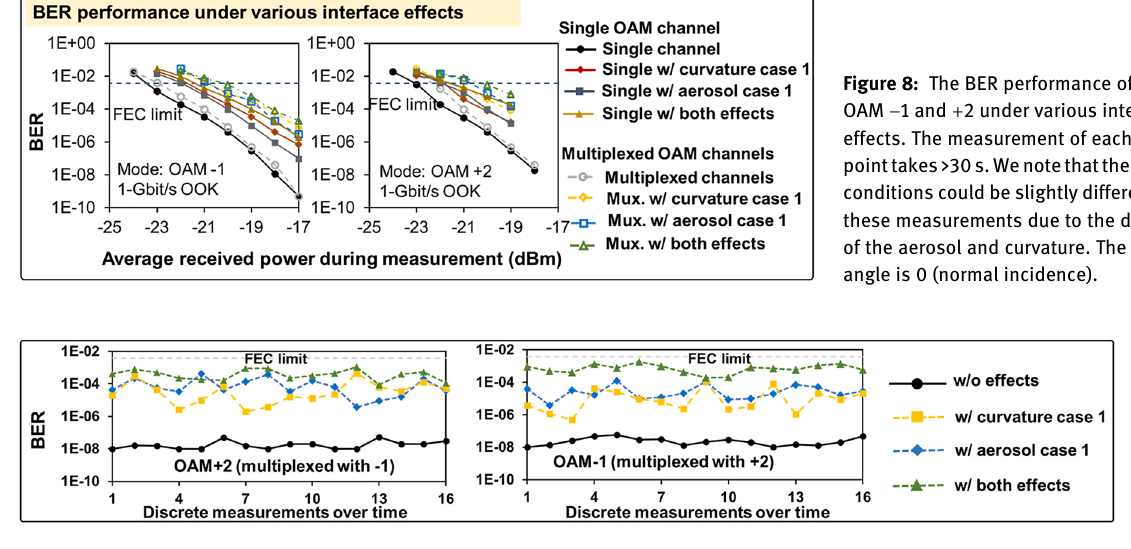
Figure 9: The BER performance for discretemeasurements (each takes ∼ 4 s) over time undervarious air – water interface effects when OAM − 1 and + 2 are multiplexed. The four BER curves in each plot are not measured at the same time, and therefore should not be compared with each other directly. The incident angle is 0 (normal incidence).